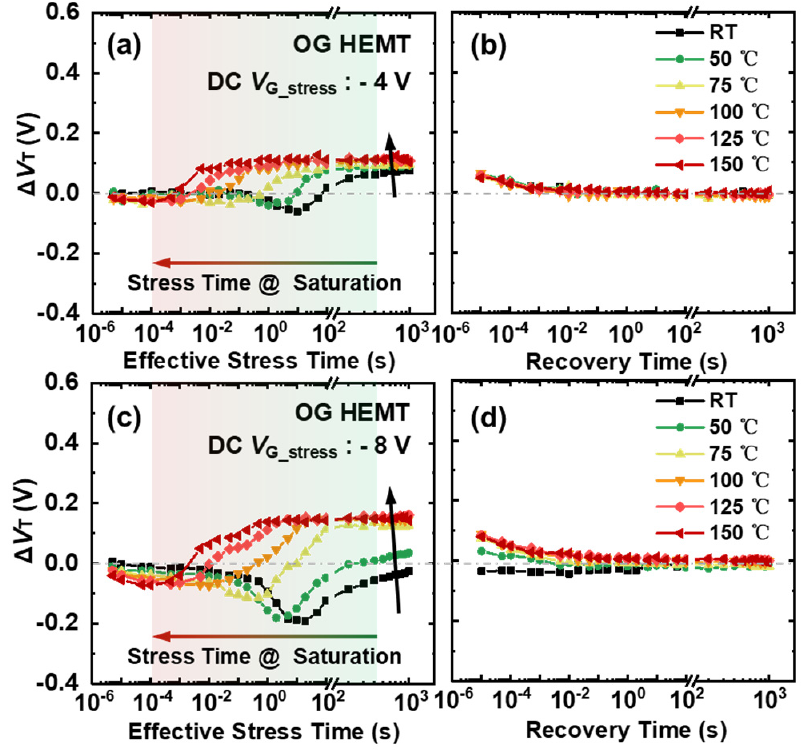
Figure 7. Δ V T evolution of OG HEMT in 1000 s stress and subsequent 1000 s recovery processes, under elevated temperature, with gate bias stress at: ( a , b ) − 4 V and ( c , d ) − 8 V.